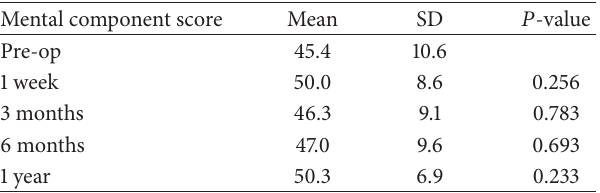
Table 3: Significance of changes in mean MCS scores of the SF-36 over the study period.